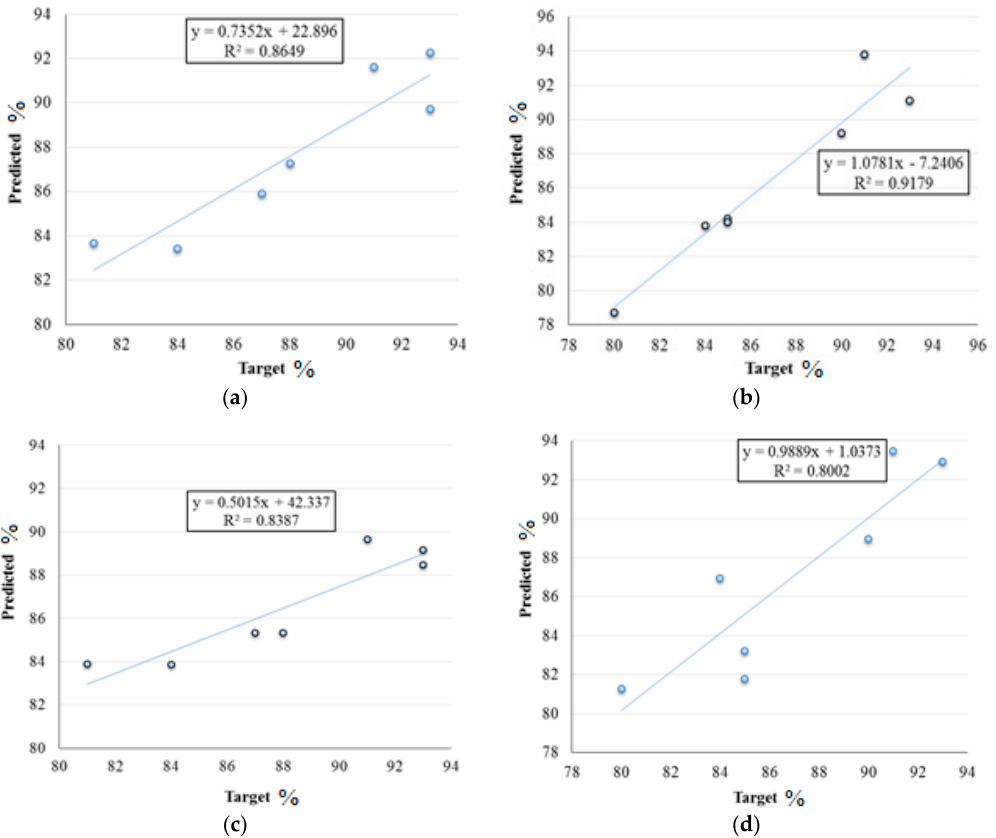
Figure 3. The scatter plot of the testing stage: ( a ) ELM -methyl ester; ( b ) ELM -ethyl ester; ( c ) SVM -methyl ester; and ( d ) SVM -ethyl ester.